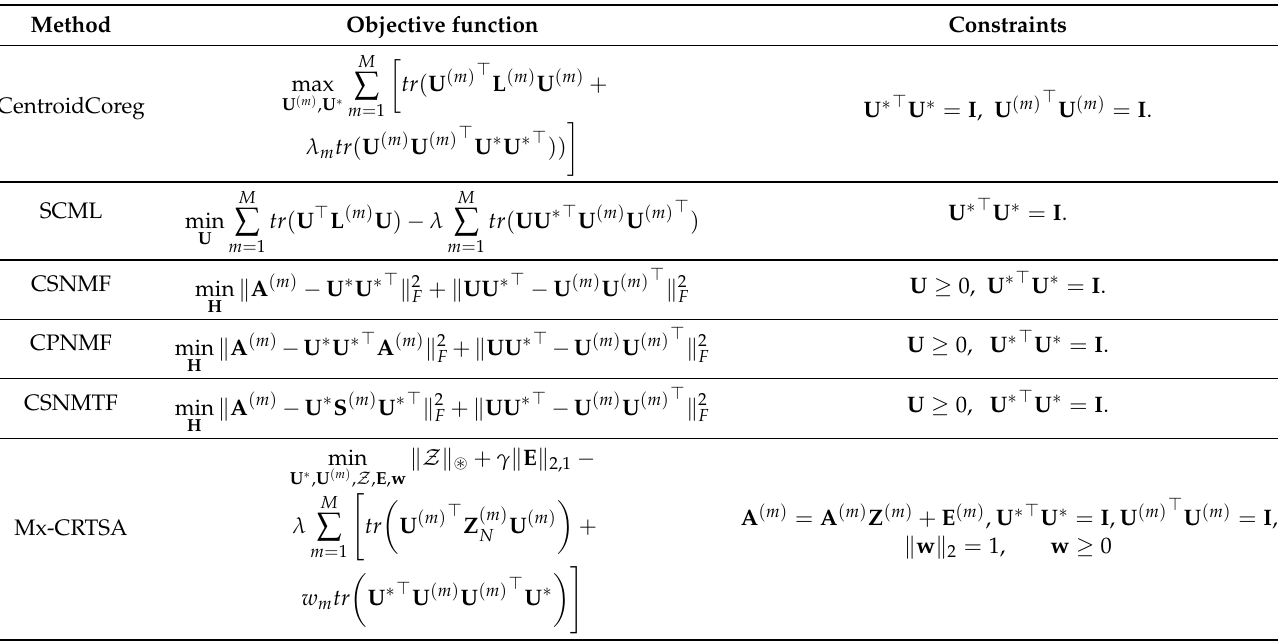
Table 2. Comparison between the objective functions of the different methods considered in the